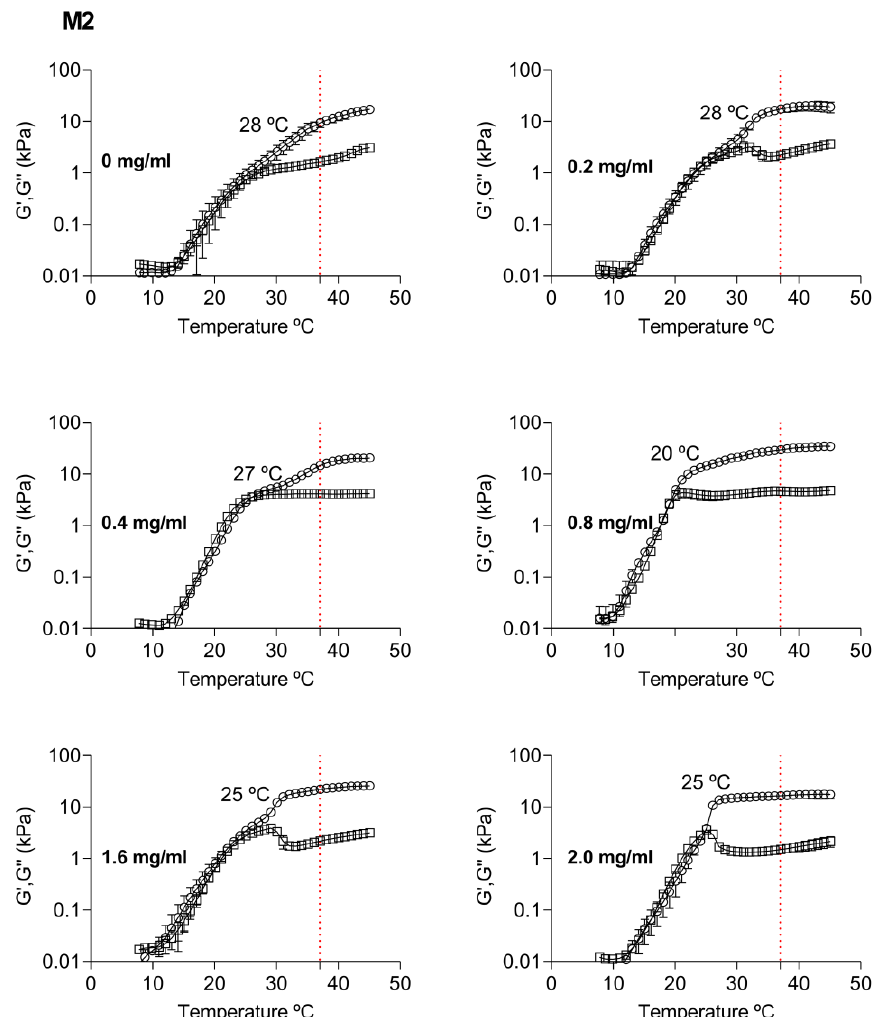
Figure 7. Rheological behavior of P407 18% casein 10% hydrogel at different concentrations of the TBH-PCL nanoparticles that were added to the casein solution, after which P407 was added into the solution (M2). Data are average ± SD (n = 4). In the vertical axis, a red dotted line refers to 37 °C, ( ○ ) storage modulus, and ( □ ) loss modulus.